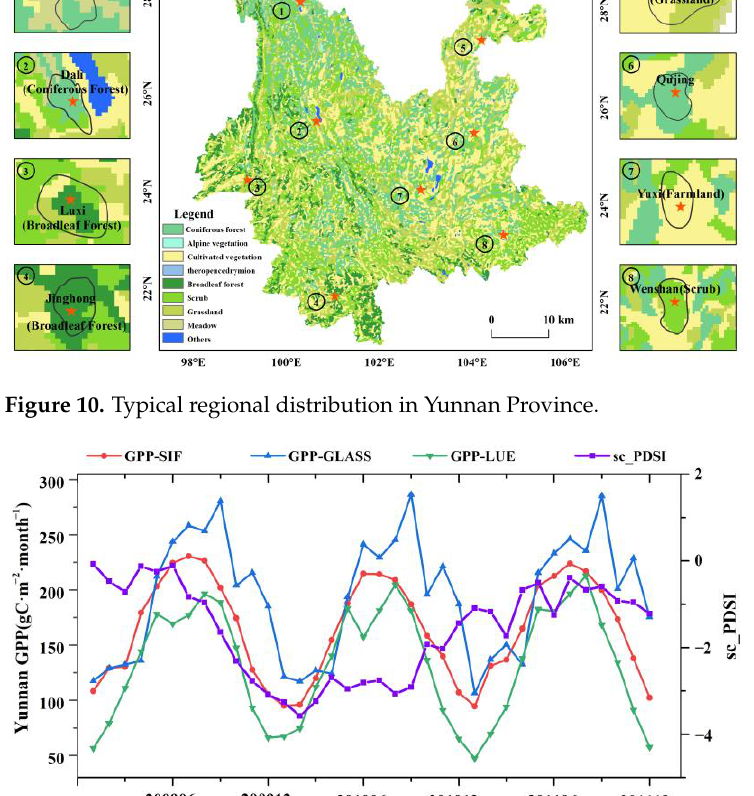
Figure 12. Changes in the three GPPs and sc_PDSI in typical regions of Yunnan Province, 2009 – 2011. (a)~(h) correspond to the data changes in areas (1)~(8) in Figure 10 respectively.